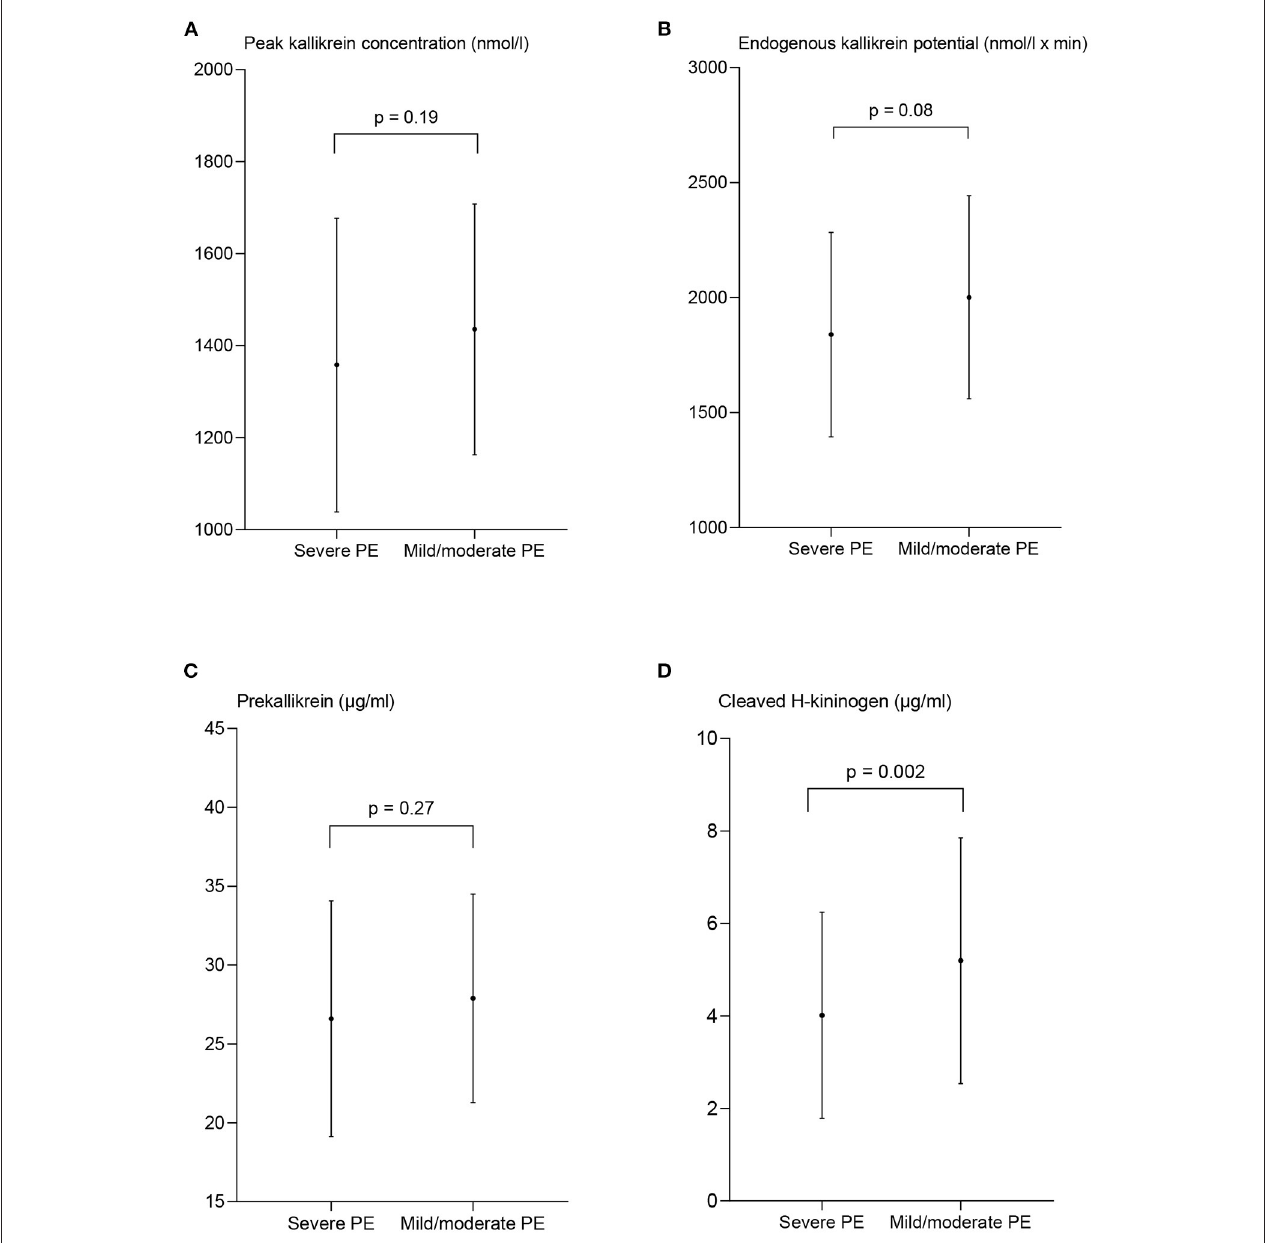
FIGURE 4 | Measures of contact activation in women with severe and mild/moderate preeclampsia (PE). The peak kallikrein concentration (A) , endogenous kallikrein potential (B) , and prekallikrein concentration (C) are presented as mean ± standard deviation. The concentration of cleaved H-kininogen (D) is presented as median and interquartile range. p -values from the paired t -test (A–C) and the Wilcoxon matched-pairs signed rank test (D) between the two patient groups.